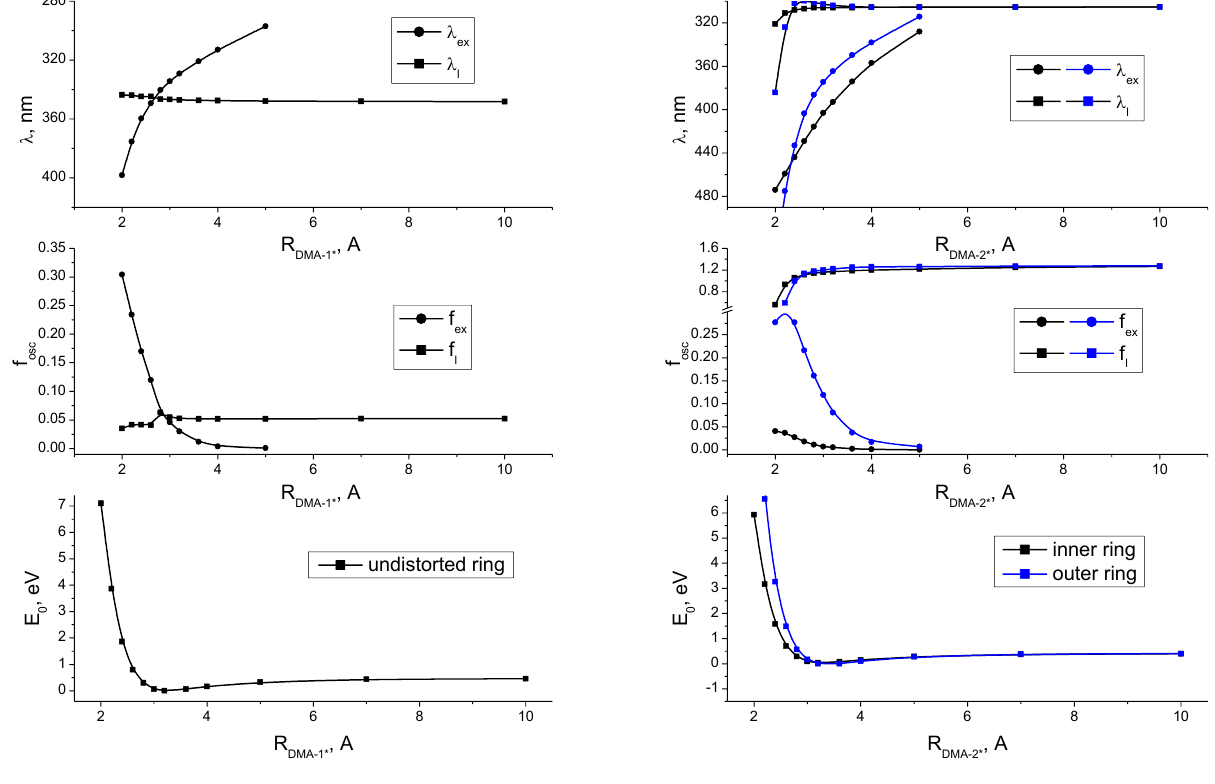
Figure 8. Total energy, E 0 ; exciplex luminescence wavelength, λ ex , and its intensity, f ex ; local lumi- nescence wavelength, λ l , and its intensity, f l ; as functions of the distance between DMA and 1 * (left panel) and DMA and 2 * (right panel). The minimum total energy is E 0 min = − 49572.46 eV for 1 , and E 0 min = − 66660.97 eV for 2 . The emission line of exciplex DMA- 1 * in the potential well minimum has a wavelength of 329 nm and an intensity of 0.03. It happens to be very close and at the blue side to the (calculated) emission line of 1 * ( λ l = 345 nm, f l = 0.052), which may be the reason why no separate line of the exciplex for 1 has been observed in the experimental spectra of X-ray-induced luminescence, while the predicted bound state is similar to 2 . Exciplex emission lines for the two considered cases of DMA- 2 * (DMA opposite to the inner or outer rings) at the potential well minimum are significantly red-shifted with respect